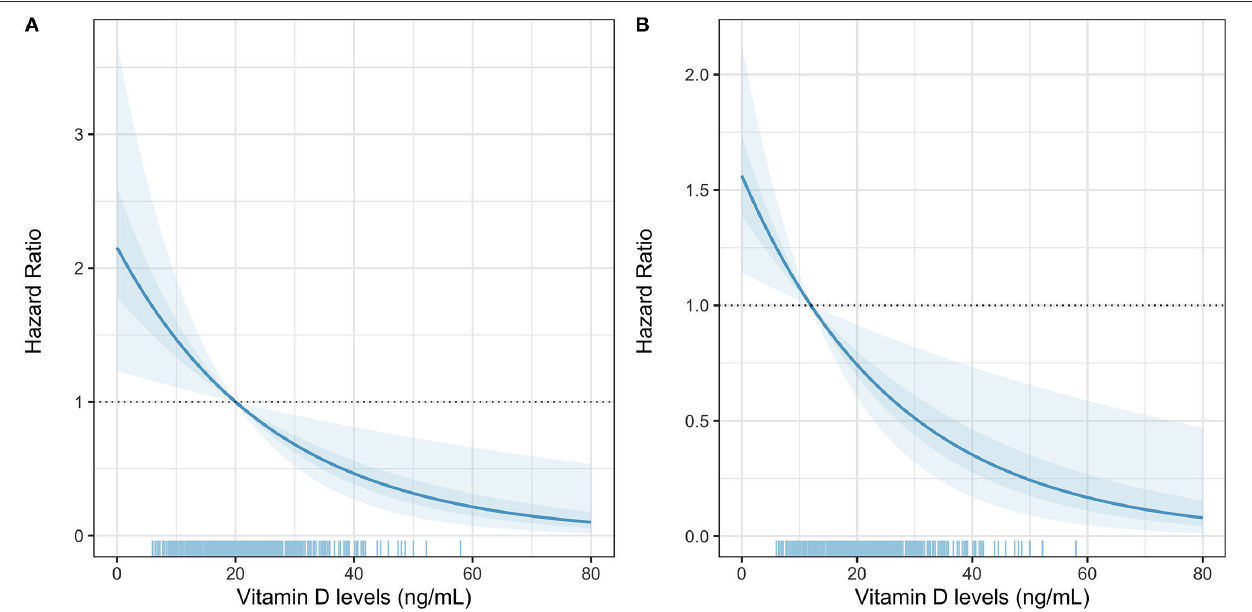
FIGURE 2 | Post-estimation simulation of Vitamin D levels to predict COVID-19 lethality, adjusted for age, sex, BMI, C-reactive protein, epicardial fat, D-dimer, oxygen saturation, T2D, and CKD using Vitamin D cut-offs of < 20 ng/dl (A) and ≤ 12 ng/ml (B)